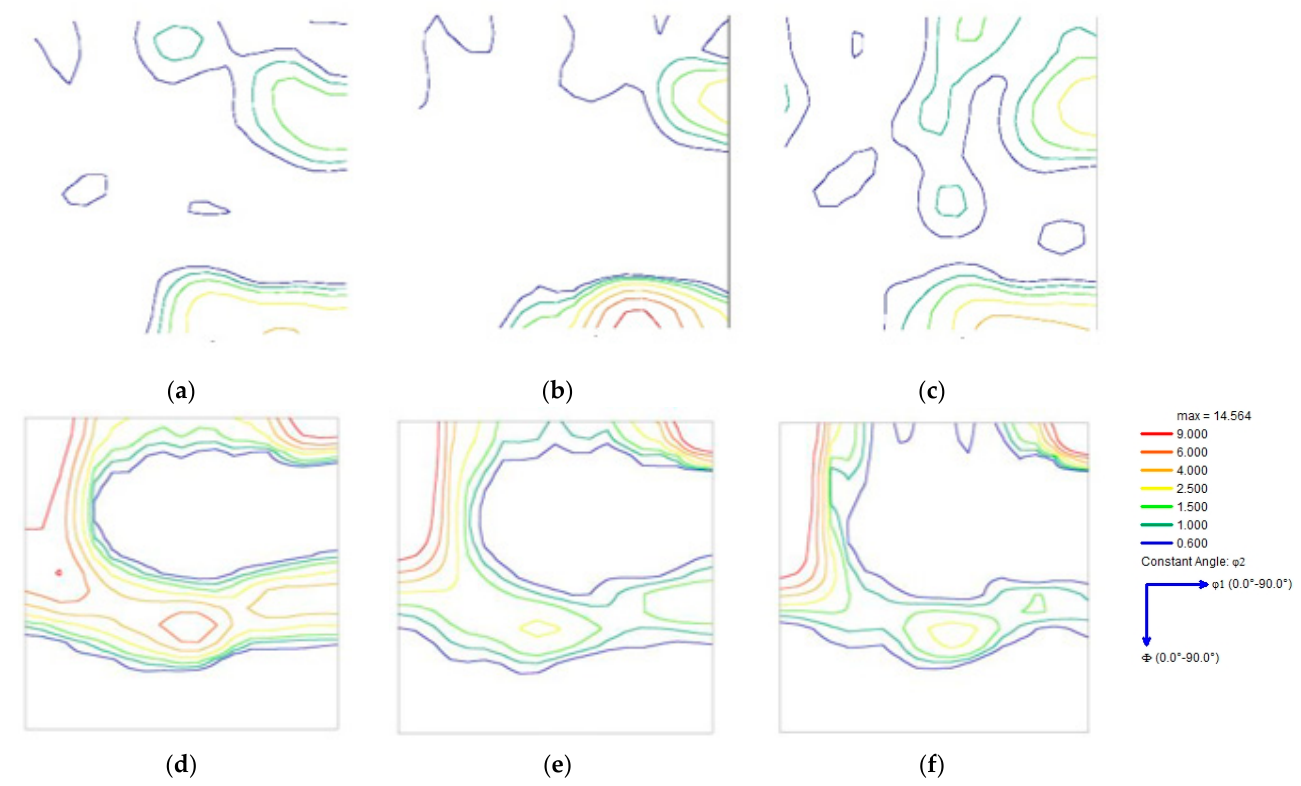
Figure 2. ODFs at φ 2 = 45° section of surface texture at different slab temperatures: ( a )1170 °C, hot rolling, ( b ) 1220 °C, hot Figure 2. ODFs at ϕ 2 = 45 ◦ section of surface texture at different slab temperatures: ( a ) 1170 ◦ C, hot rolling, ( b ) 1220 ◦ C, rolling, ( c ) 1270 °C, hot rolling, ( d ) 1170 °C, single ‐ stage cold rolling, ( e ) 1220 °C, single ‐ stage cold rolling, ( f )1270 °C, single ‐ hot rolling, ( c ) 1270 ◦ C, hot rolling, ( d ) 1170 ◦ C, single-stage cold rolling, ( e ) 1220 ◦ C, single-stage cold rolling, ( f ) 1270 ◦ C, stage cold rolling. single-stage cold